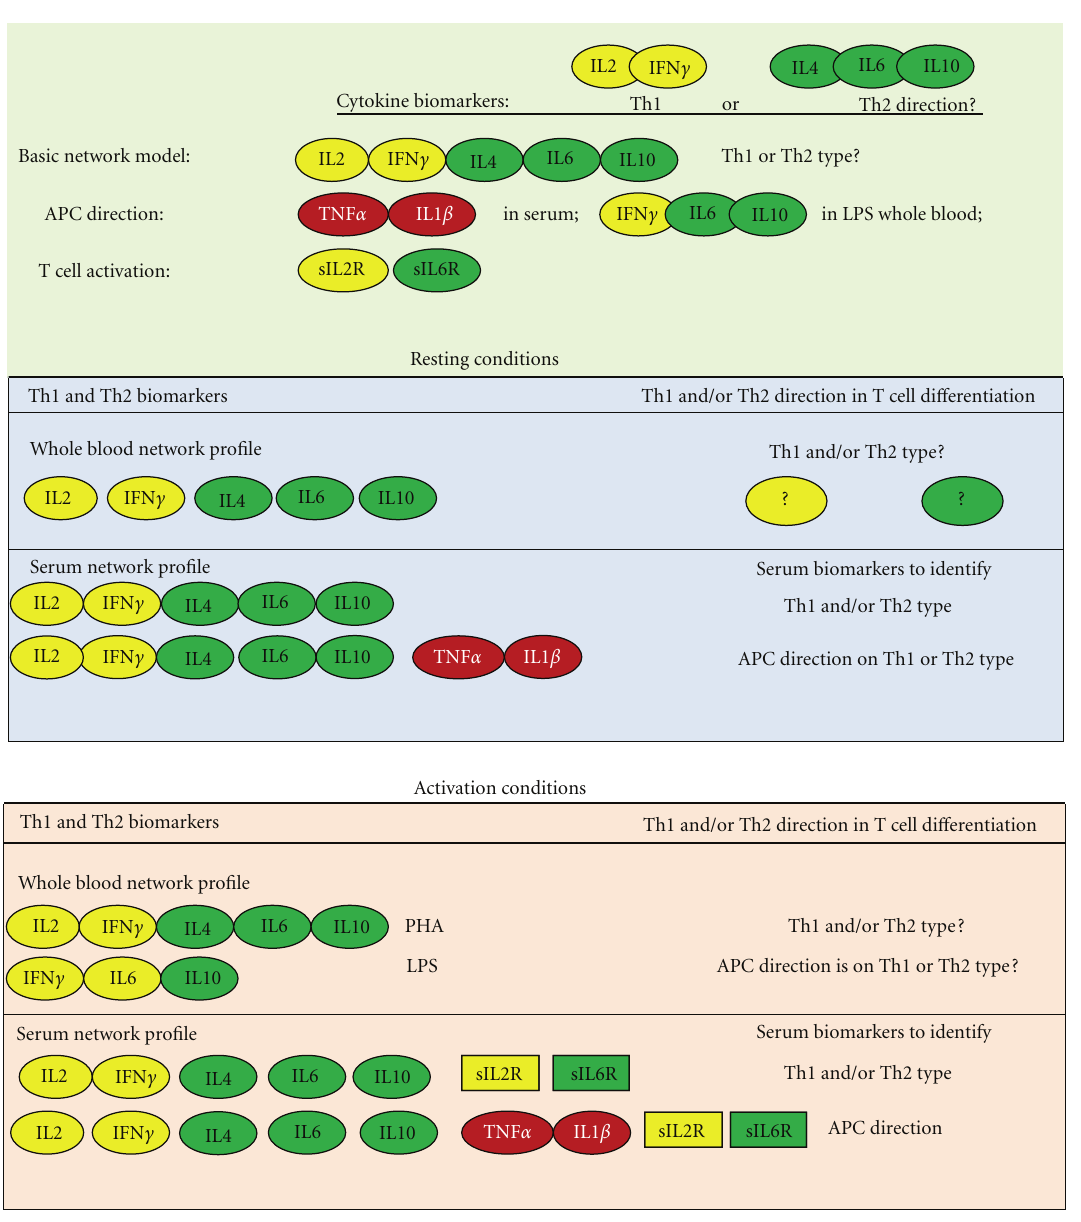
Figure 4: Th-cytokine models of the immune response in resting and activation conditions: whole blood levels of specific Th1 and Th2 cytokines were used as biomarkers in Th-cytokine data-driven computational models of the immune response to determine the direction of T cell di ff erentiation (Th1 or Th2). The cytokines used in our Th-cytokine data-driven computational models of the immune response were: interleukin (IL)-2, interferon (IFN) γ , IL-4, IL-6, and IL-10, to make up our basic network model, to establish if the direction in T cell di ff erentiation was Th1 and/or Th2 type; tumor necrosis factor (TNF) α and IL-1 β as serum biomarkers and IFN γ , IL-6, and IL-10 as LPS whole blood biomarkers, to determine if APC direction on T cell di ff erentiation was of Th1 or Th2 type; and soluble (s) IL-2 receptor (R) and sIL-6R to estimate cell activation. APC: antigen presenting cells; PHA: to study T cell network contribution; LPS: to evaluate the influence of antigen presenting